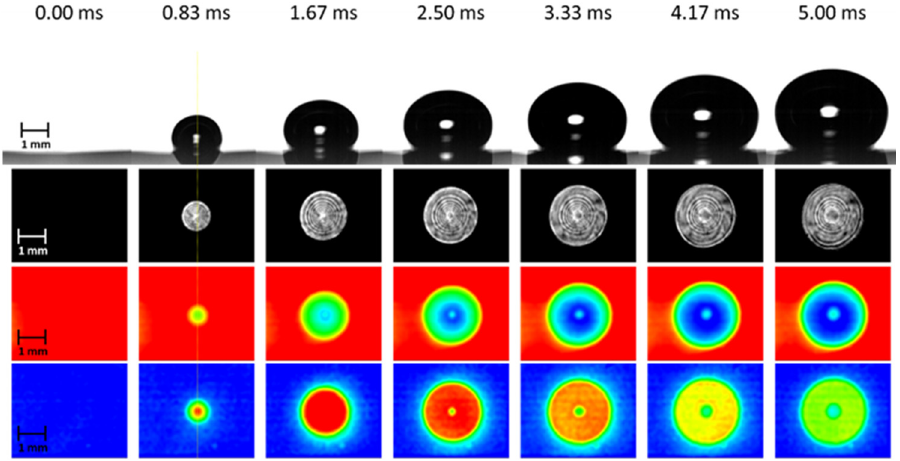
Figure 2. Complementary observations of the early stages of bubble growth at a solid surface [3]. From top to bottom: bubble side view, phase distribution on the heated surface, temperature distribution at the solid surface, and surface normal heat flux distribution derived from the temperature distribution.